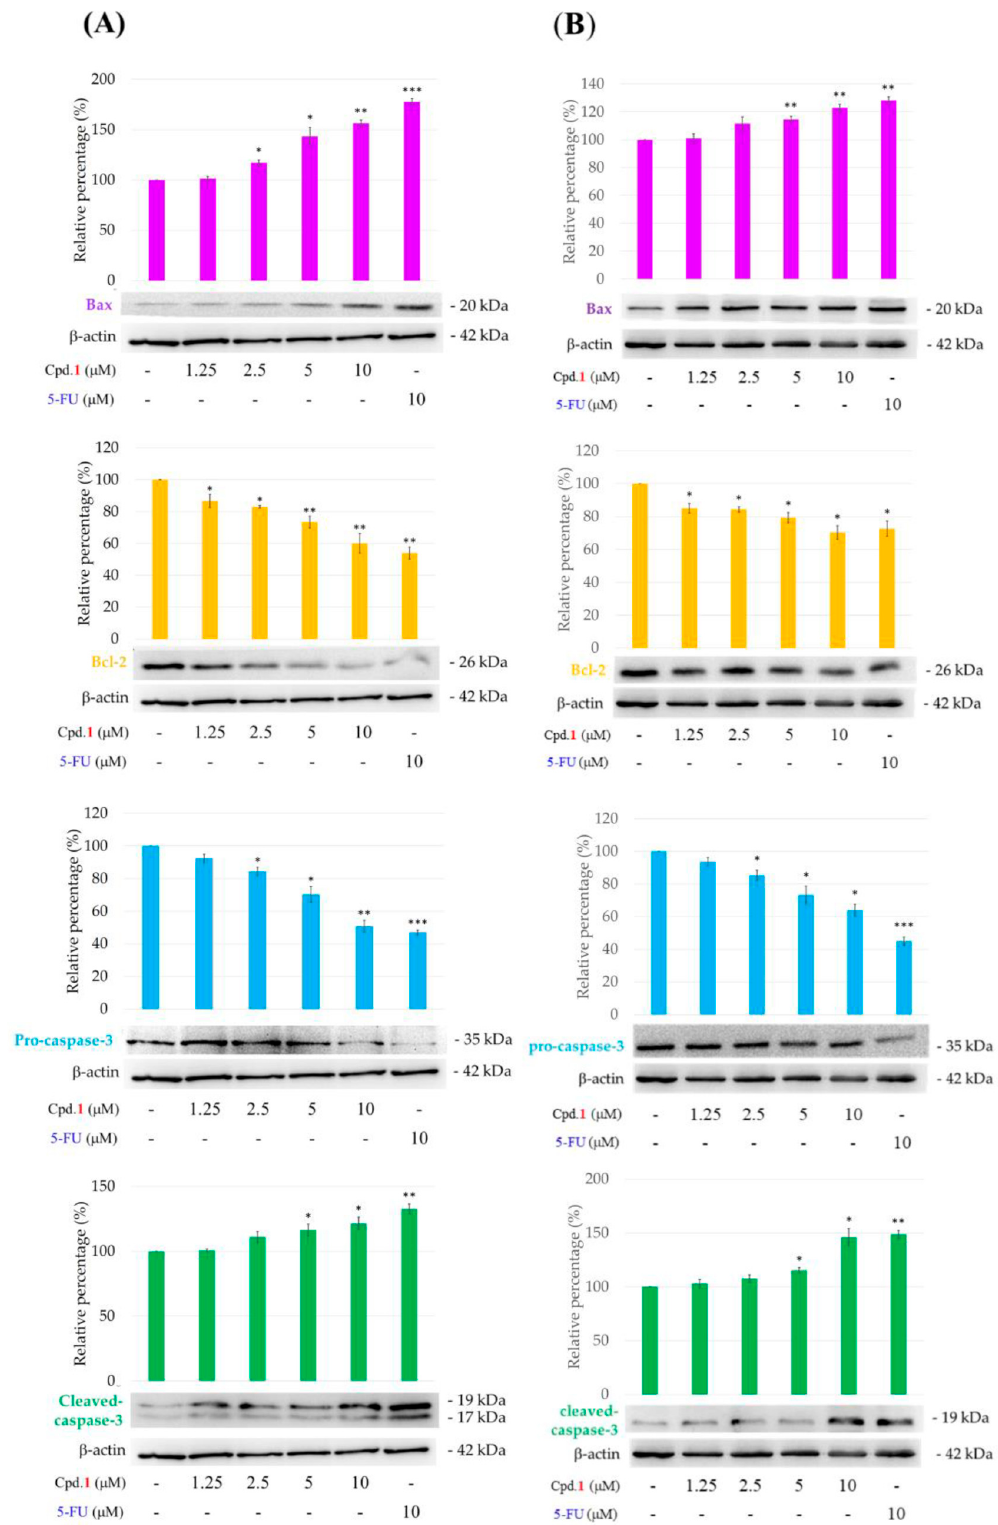
Figure 9. Compound 1 inhibited the anti-apoptotic protein Bcl-2, increased pro-apoptotic protein Bax, and activated caspase-3 in A549 ( A ) and MCF-7 ( B ) cells. Cells were treated with 1 (1.25–10 μ M) for 72 h. Bcl-2, Bax, pro-caspase-3, and cleaved-caspase-3 were analyzed by immunoblotting. Densitometric analysis of tested compounds was normalized to the corresponding expression of β -actin. The data were expressed as means ± SEM ( n = 3). Asterisks indicate significant differences (* p < 0.05, ** p < 0.01, and *** p < 0.001) compared to the control group.